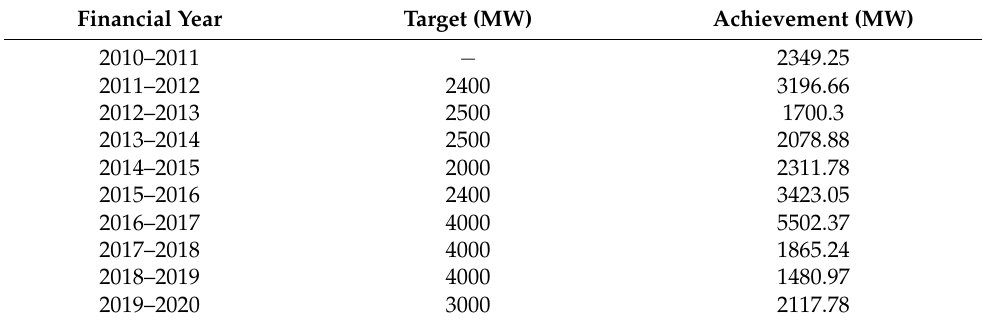
Figure 16. Cumulative installed capacity of grid-interactive renewable power by type (in MW). Source: Ministry of New and Renewable Energy [64]. Table 17. Capacity additions; target and achievements (MW) from 2010–2020. Source: India Energy Outlook